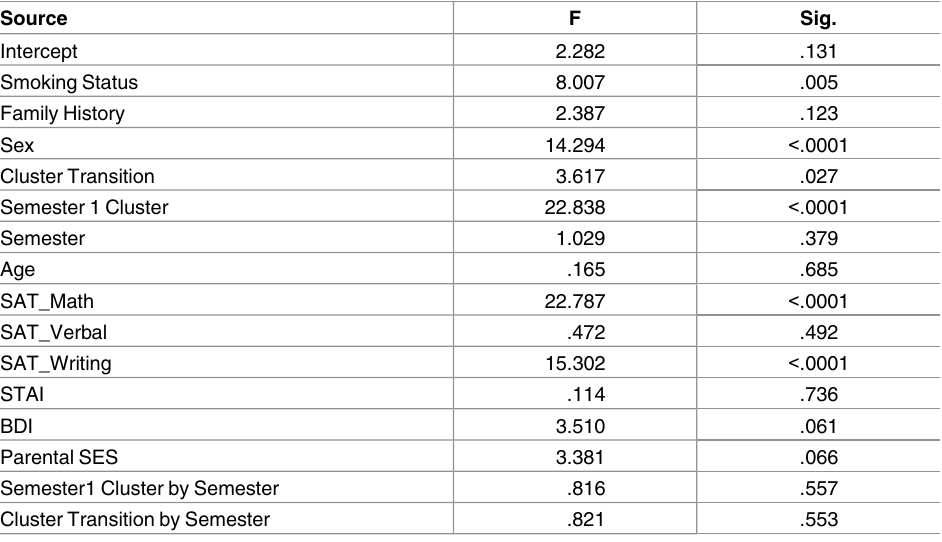
Table 2. Fixed effects from the linear mixed model conducting the pseudo